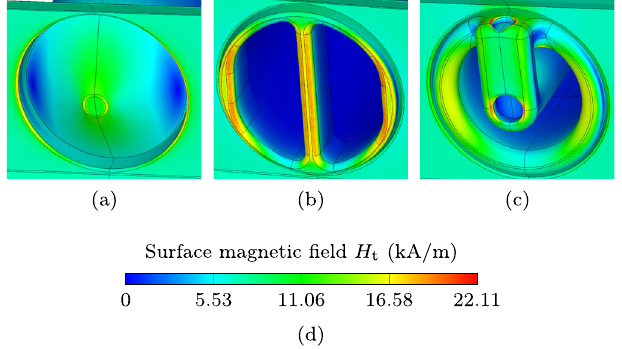
FIG. 28. Surface magnetic field H vacuum pumping port (b), as well as input power coupler (c), and (d) legend.